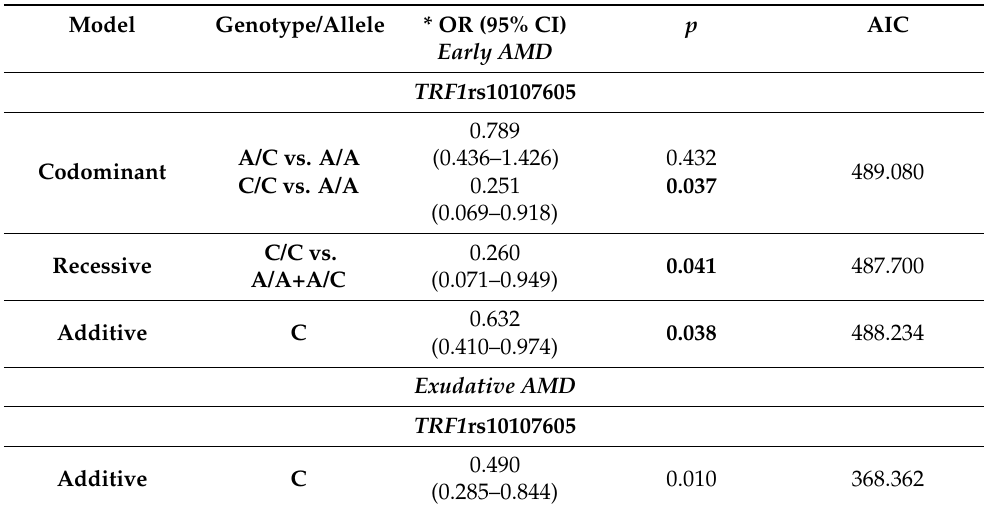
Table 4. Binomial logistic regression analysis of TRF1 rs10107605 in patients with early and exudative AMD.